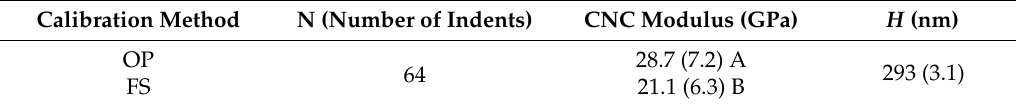
Table 3. The nanomechanical properties of